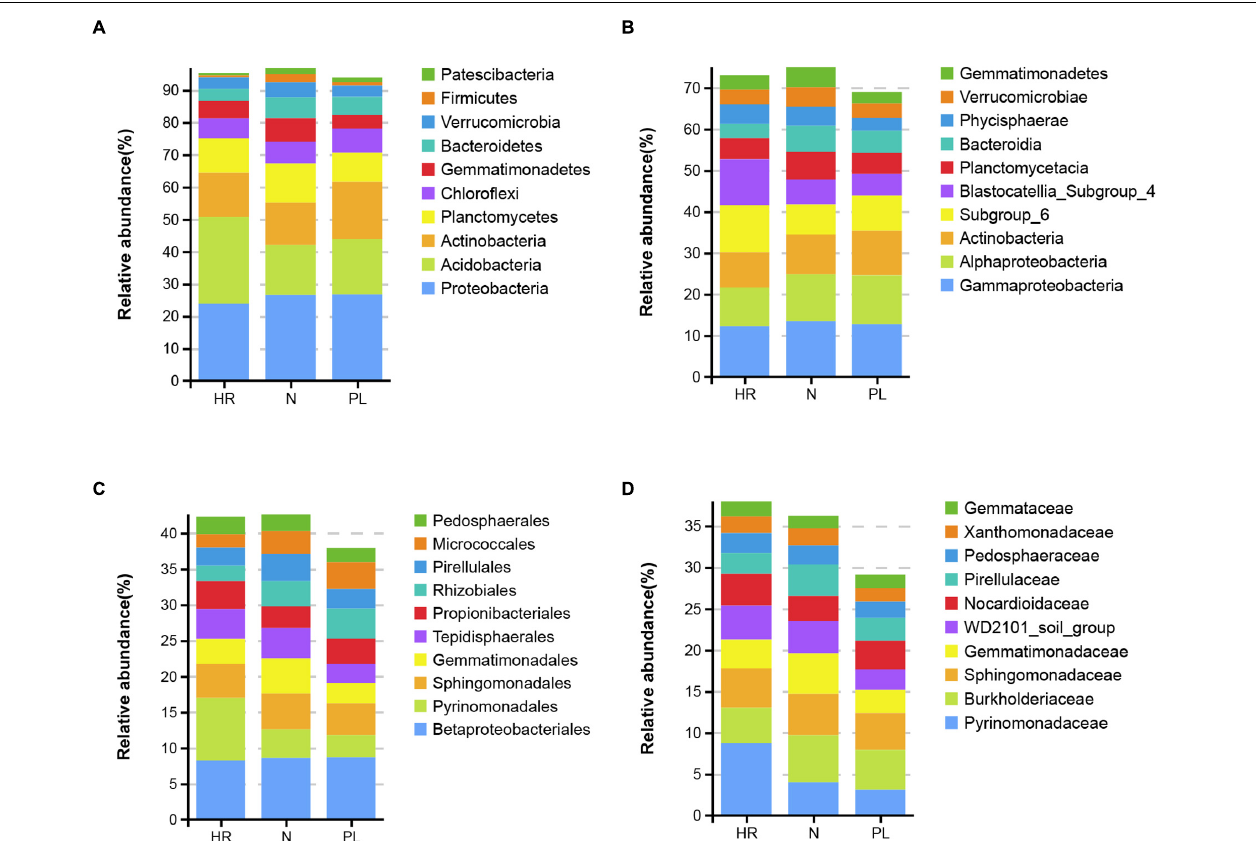
FIGURE 3 | Top 10 relative abundances of bacterial communities classified at the phylum (A) , class (B) , order (C) , and family (D) levels in different rhizospheric soils. N, soil from the C. yanhusuo field without rotation; HR, soil from the C. yanhusuo field that had been flooded in July 2020; PL, soil from the field under peanut– C. yanhusuo